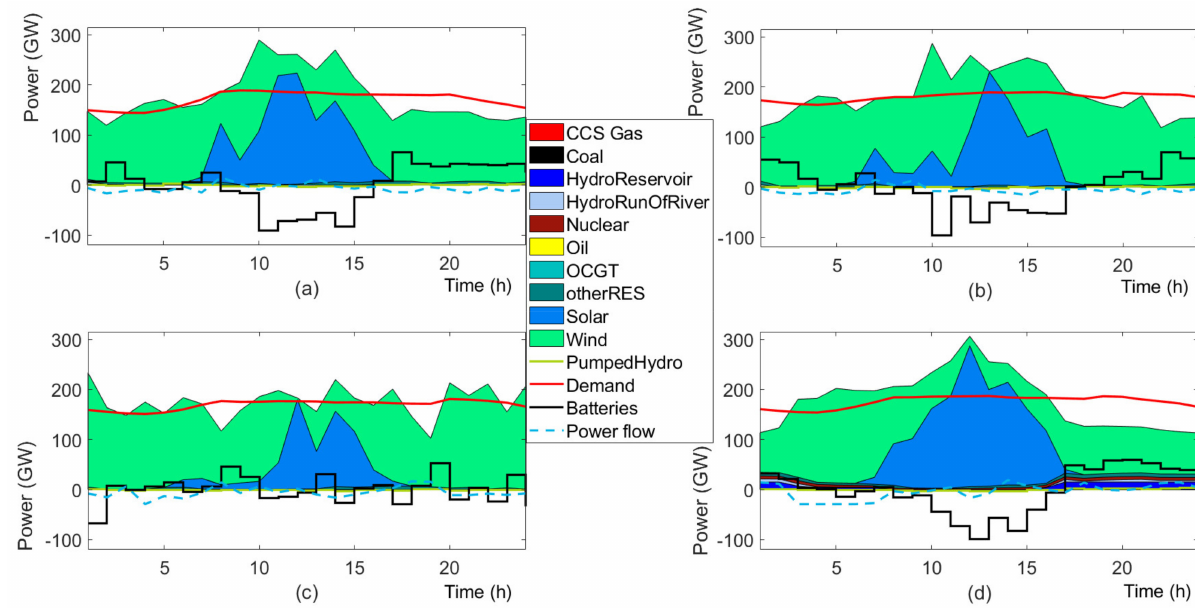
Figure 18. Generation mix in region SR according to scenario node 8 with the availability of storage, in four typical days. Figure ( a ) reports a typical day within the period January–March, ( b ) a typical day within April–June, ( c ) a typical day within July–September, and ( d ) a typical day within October–December.